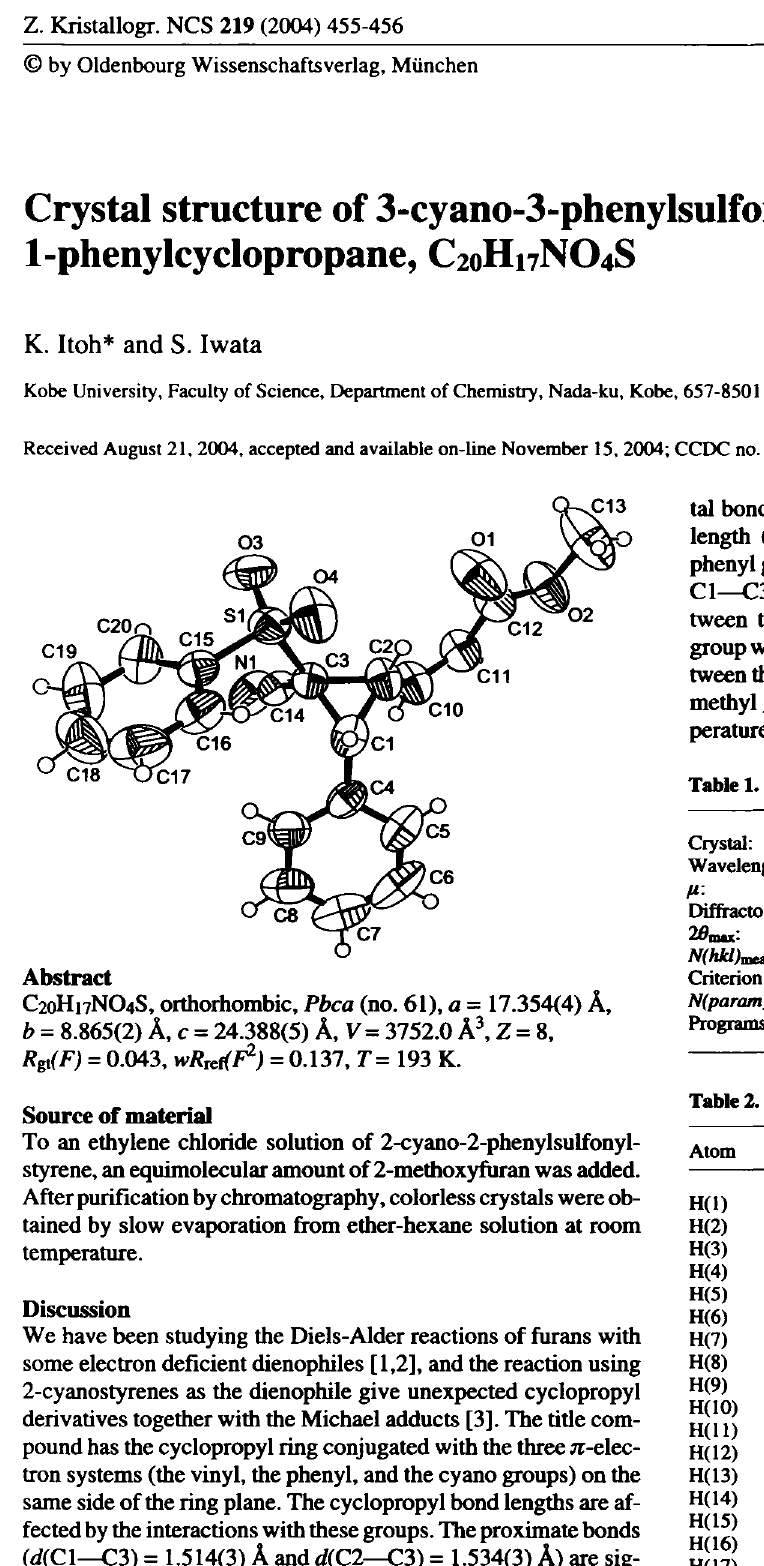
Table 3. Atomic coordinates and displacement parameters (in A 2 ).